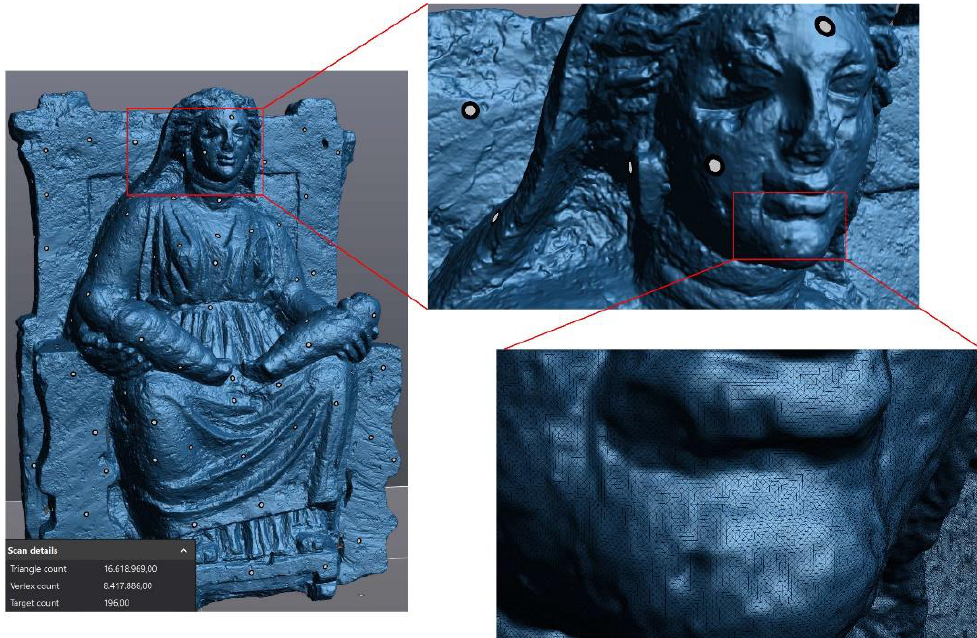
Figure 7. Result of the laser scanning process.